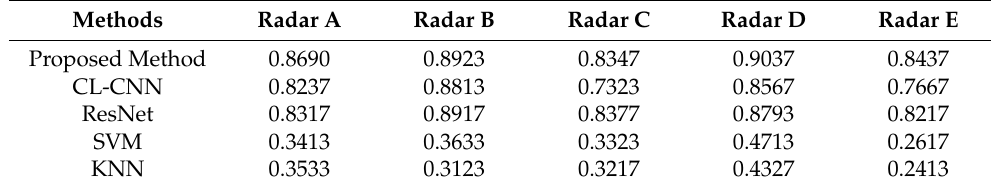
Table 3. Comparison of the classification accuracy of five radars by different methods ( − 5 dB).